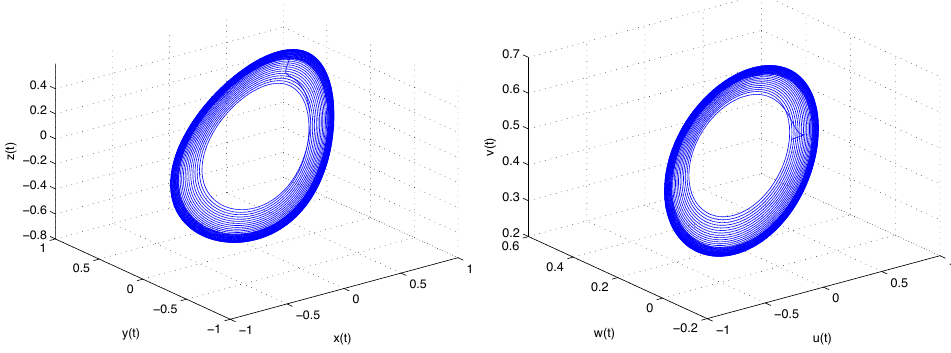
Figure 5. Orbits of the fractional-order oscillator (22) in state spaces x − y − z , u − w − v , respectively. Figure 6 depicts the simulation results of the system (22) in state space, using numerical solution (23), for the parameters: a = 1.73, b = − 2.04, d = 0.51, e = 0.04, f = 0.67, g = 0.19, h = 0.48, j = 0.52, k = n 1 = n 2 = 0.21, m 1 = 1, m 2 = 0.001, p = 3 dm 2 , r = 3 em 2 , orders γ 1 = 0.99 (capacitor), γ 2 = 0.98 (memcapacitor), γ 3 = 0.96 (meminductor), γ 4 =